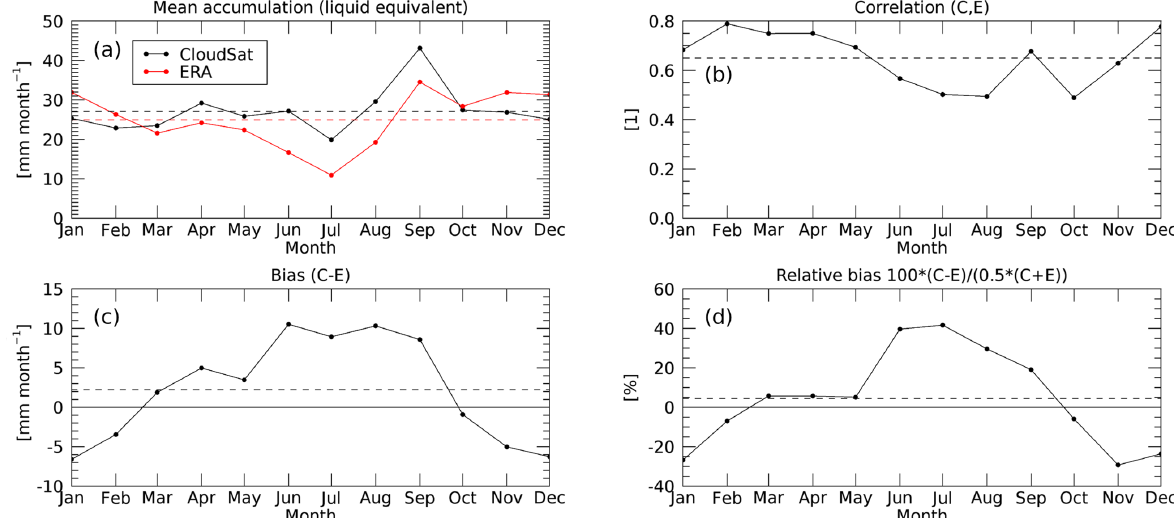
Figure 15. Annual cycle of liquid equivalent snowfall over the GrIS from CloudSat and ERA-Interim (a) , spatial correlation between the two (b) , mean bias (c) , and mean relative bias (d) . The dashed horizontal lines represent the annual